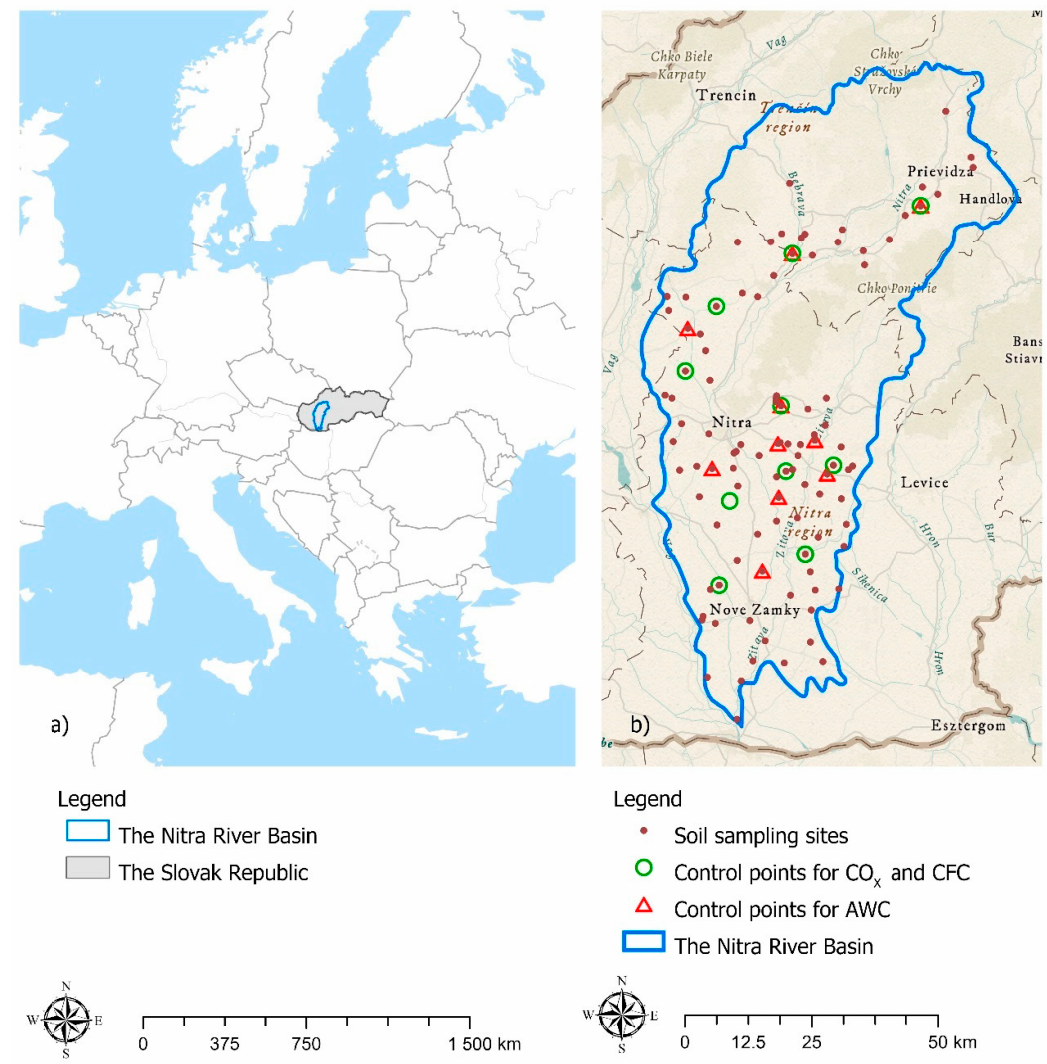
Figure 1. Study area: ( a ) Position of the Nitra River Basin; ( b ) Location of the soil sampling sites and control